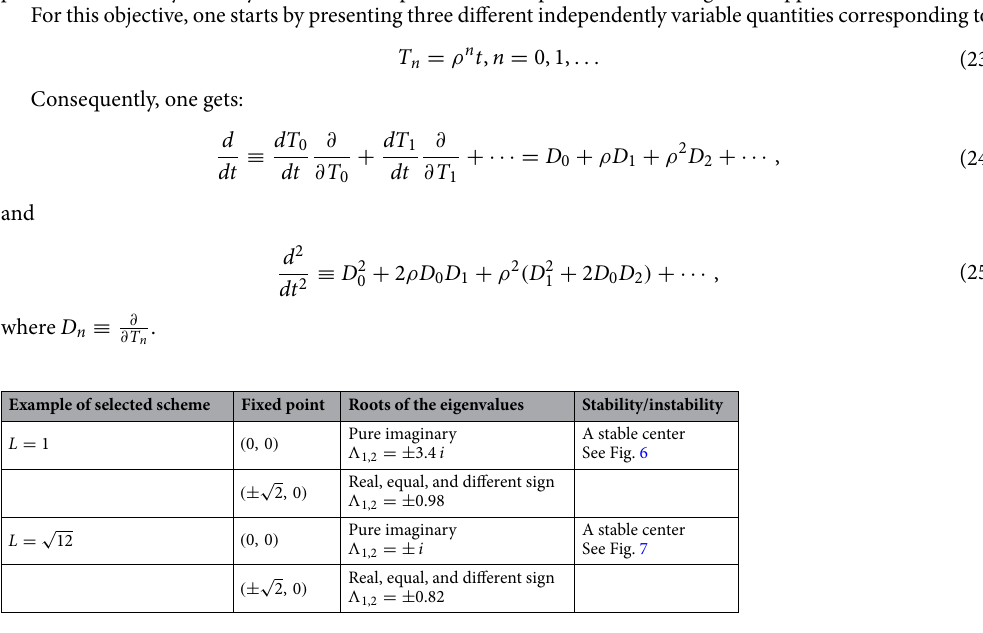
Table 1. Demonstrates the different eigenvalue